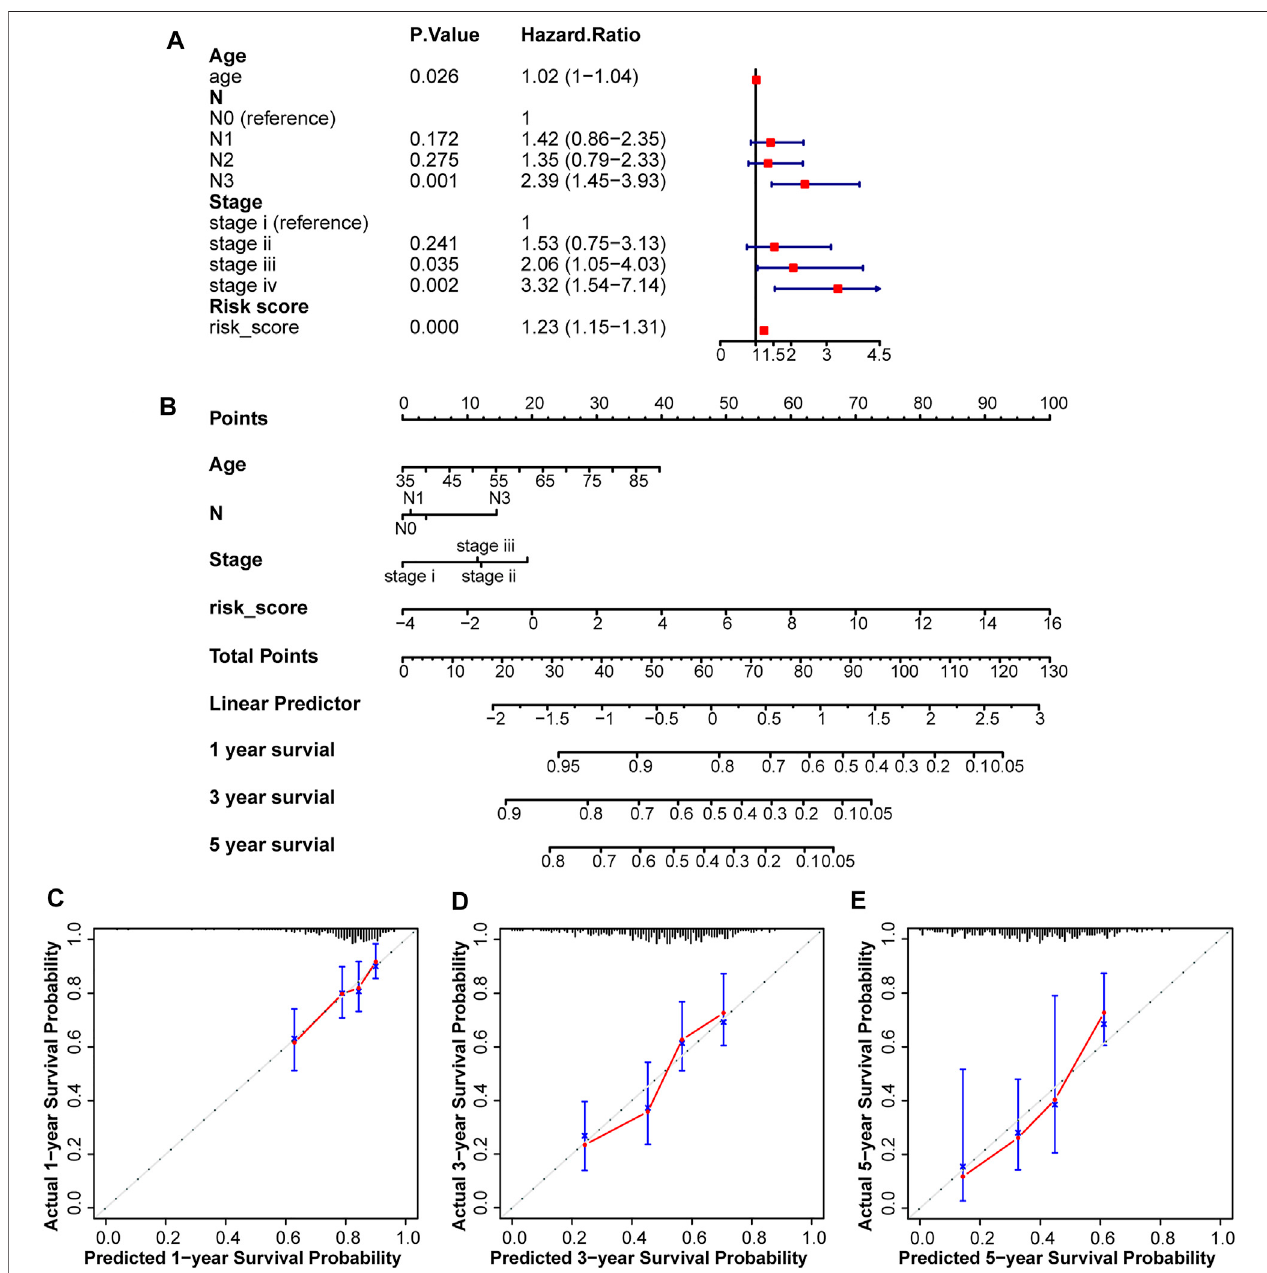
FIGURE 4 | Construction and assessment of a nomogram in the test2 cohort. (A) Four factors including age, pathological N, tumor Stage, and risk score, were foundtoberelatedtoprognosis. (B) Anomogramwasconstructedtopredictoverallsurvivalratesat1-,3-,and5-years. (C – E) Calibrationcurveswereplottedtoassess agreement between the predicted and actual OS